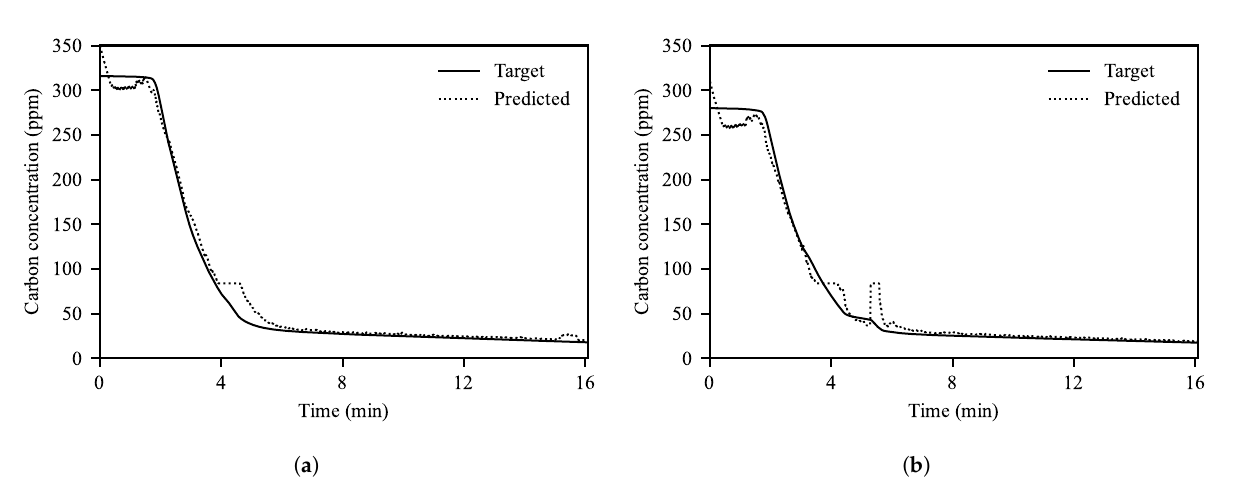
Figure 6. Prediction results of the ANN model for the target decarburization curves in two example operations ( a ) without and ( b ) with additional carbon. The solid and dotted lines represent the decarburization curve using the TDLAS analyzer and the predicted values of the ANN model,